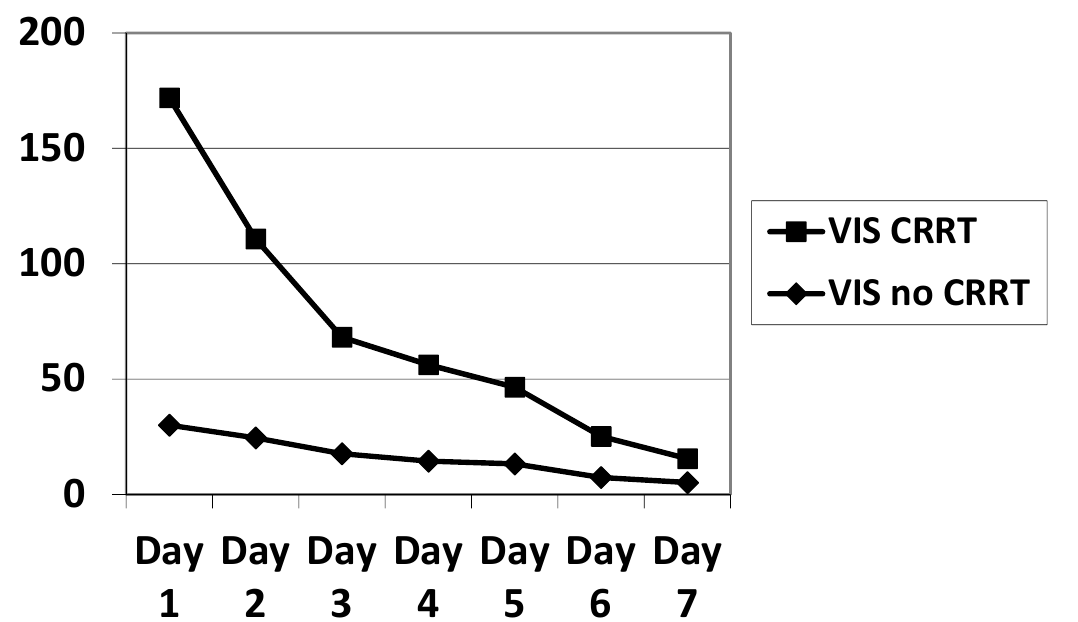
Figure 2. Evolution of the VIS during the 7 days of ECMO. VIS significantly elevated ( p < 0.05) on day 1, 2, 3 in the CRRT population. VIS: vasoactive inotropic score; ECMO: extracorporeal membrane oxygenation.